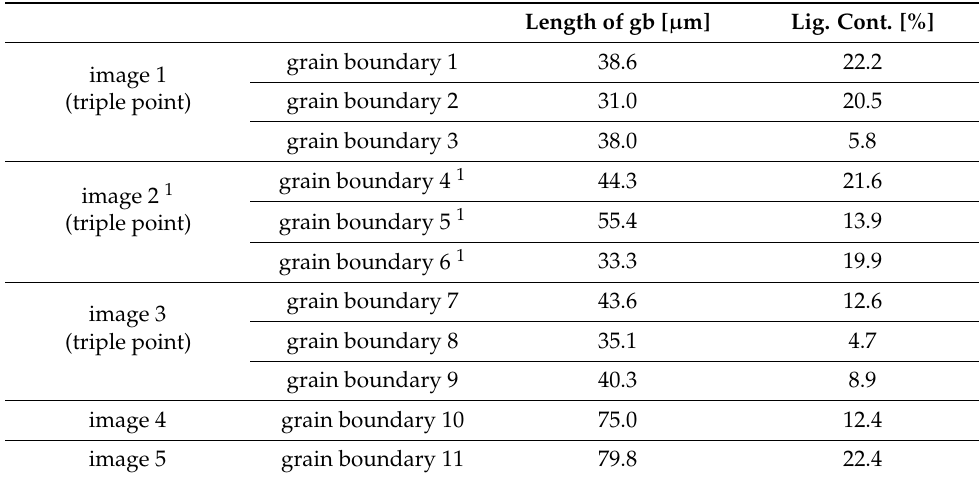
Table 1. Amount of ligaments at the grain boundaries (lig. cont.). For every grain boundary (gb) only a part of it was evaluated. The length given here is of that evaluated segment.